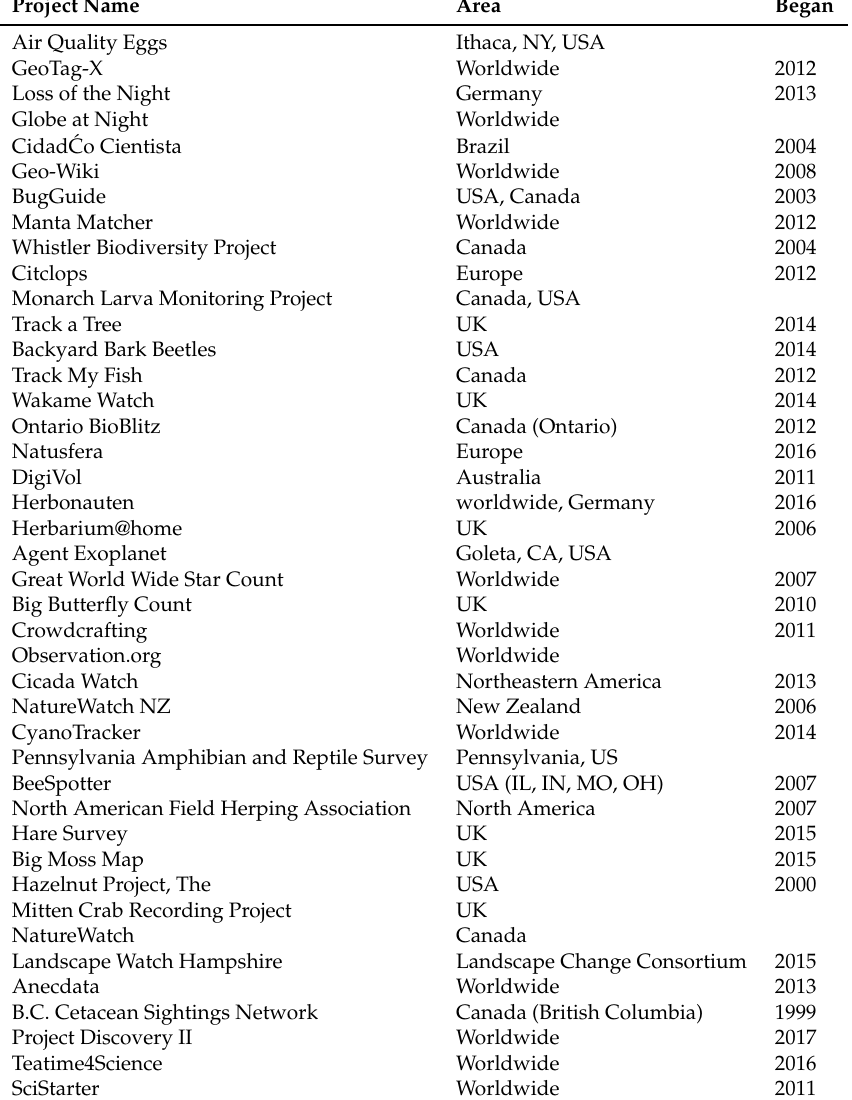
Table A1. First half of accepted and analyzed